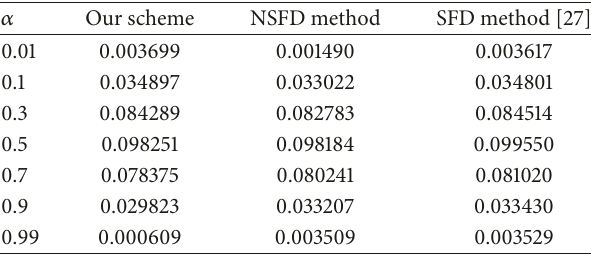
Table 2: Error norm 𝐿 ∞ for Example